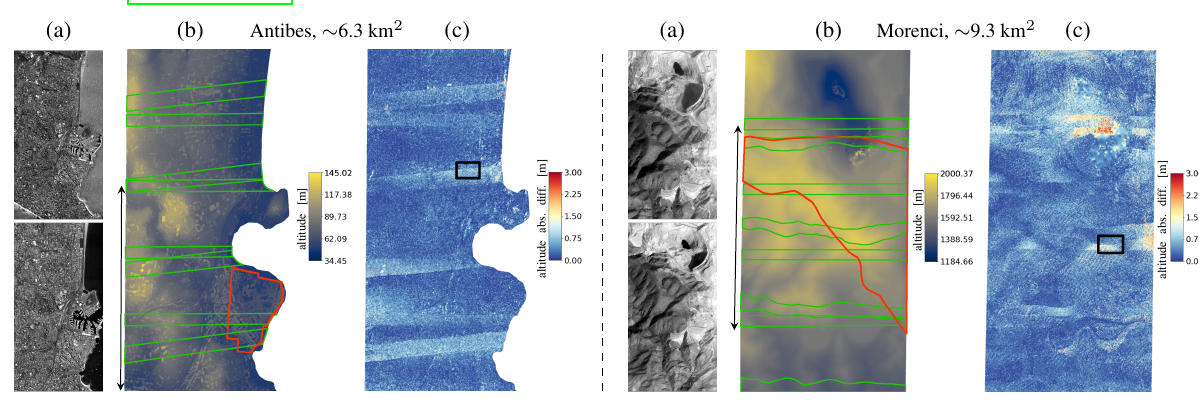
Figure 4. (a) 3D grid used for RPC fitting, for a strip of 3 scenes. The z coordinate is the altitude of the points in meters, while x and y correspond to their projection in the image plane. Point colors depend on the scene of the strip that was used to localize each 3D point. (b) Error of the perfect sensor localization model across the 3D grid, in pixel units. The reference points used by the bundle adjustment (Marí et al., 2021a) in the prior correction of the local RPCs are shown in blue. (c) Front view of the error distribution.